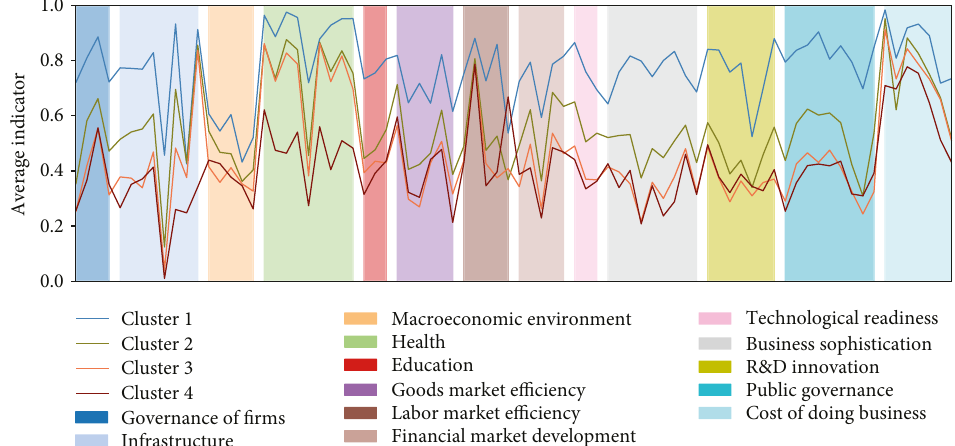
Figure 1: Gaps in socioeconomic indicators between development clusters in 2016. The X -axis corresponds to development indicators, organized by development pillar. The wider the shaded area, the more development indicators within the corresponding pillar. For countries without observations for 2016, we take the most recent